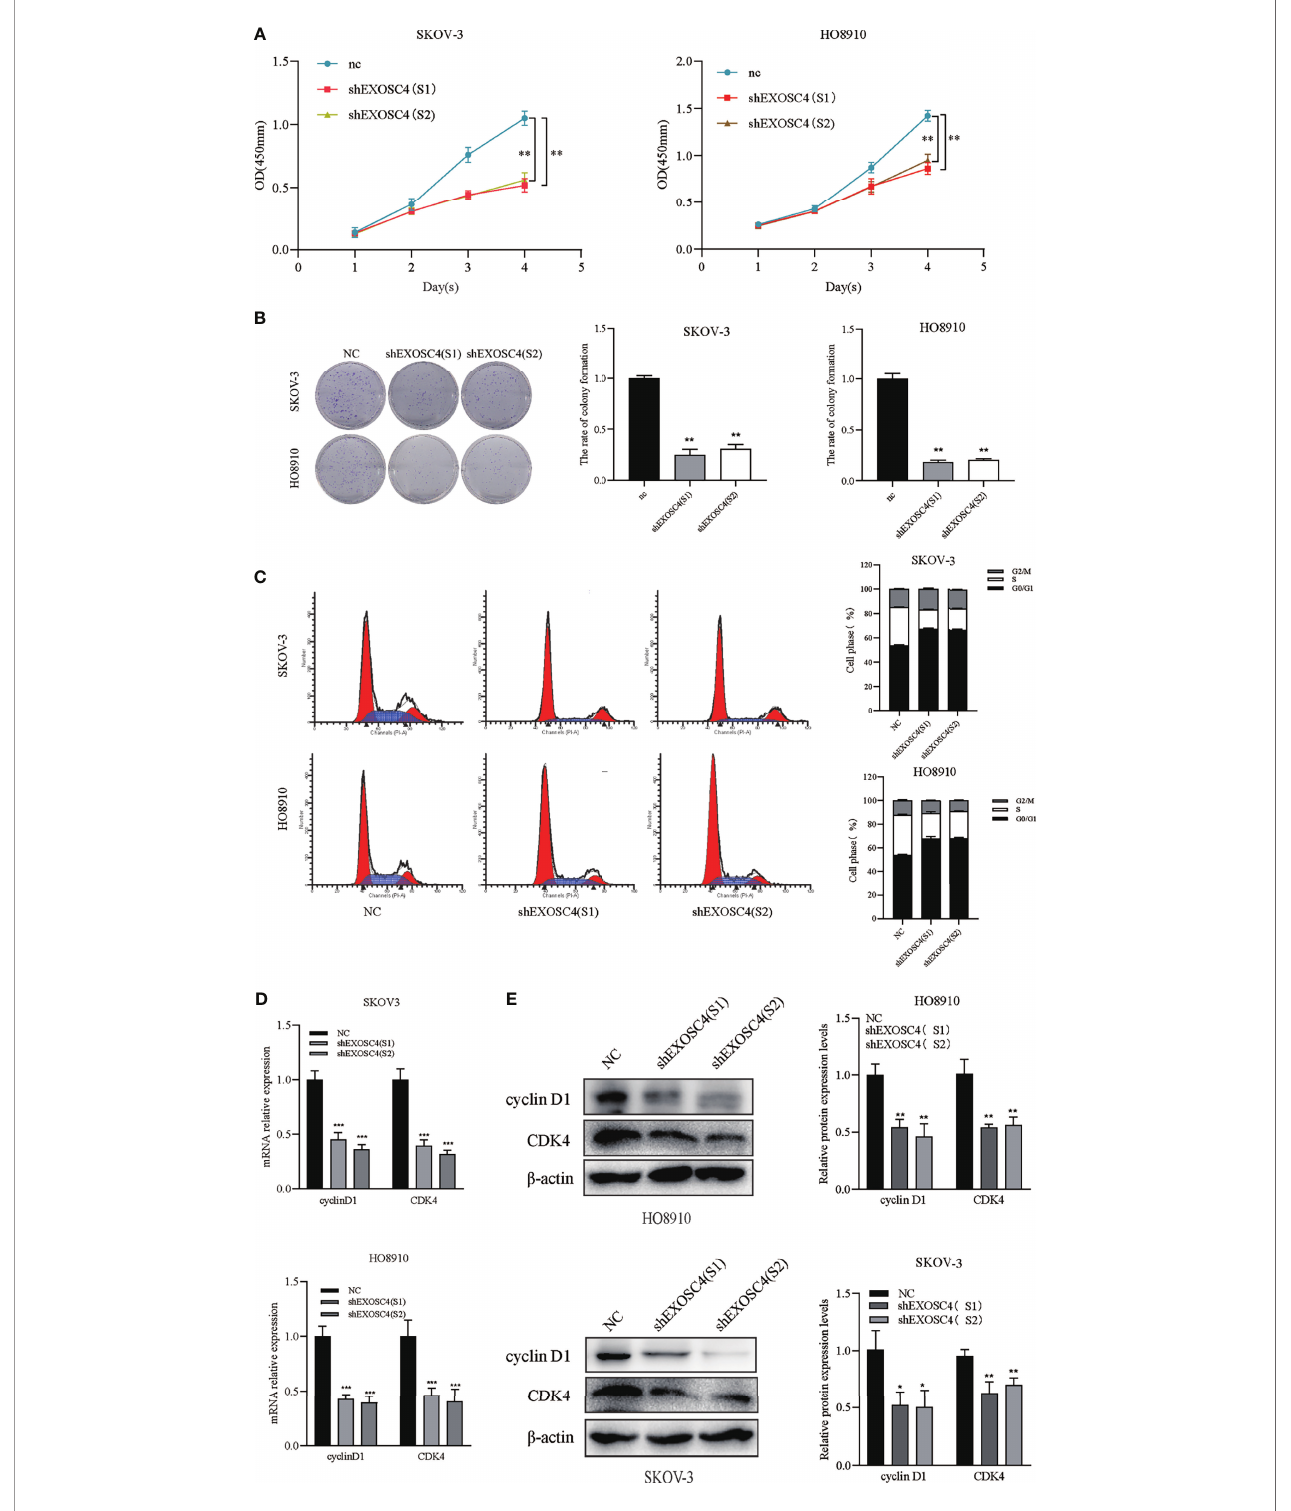
FIGURE 3 | Knockdown of EXOSC4 inhibits cell proliferation, and induces G0/G1 arrest in the SKOV-3 and HO8910 cell lines. (A) CCK8 assays showed that knockdown of EXOSC4 inhibited cell proliferation in SKOV-3 and HO8910 cells. (B) Clone formation ability was also reduced by EXOSC4 knockdown. (C) Cells were arrested at G0/G1 phase following EXOSC4 knockdown. (D) mRNA levels of cyclin D1 and CDK4 detected by RT-PCR. (E) Western-blot assays to determine the protein levels of cyclin D1 and CDK4, and its band quanti fi cation. *p < 0.05, **p < 0.01, ***p <